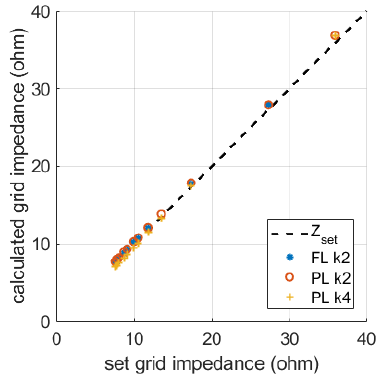
Figure 4. Set and measured grid impedance magnitude.